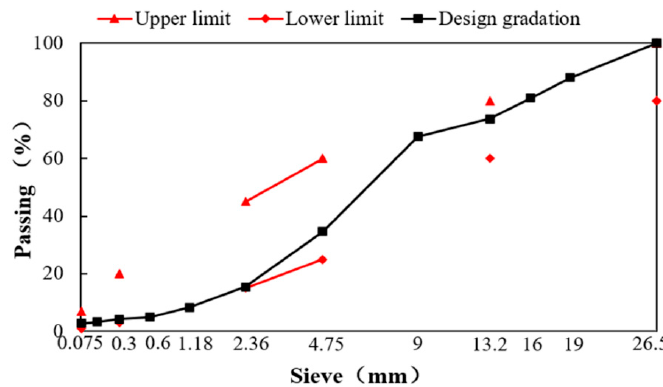
Figure 2. The gradation of CRME.